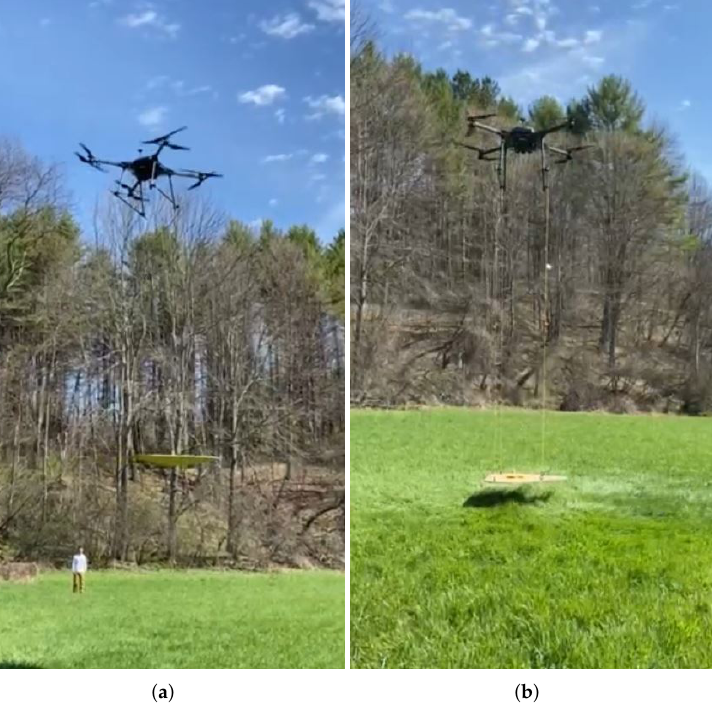
Figure 4. Mock platform maneuverability testing. ( a ) Large standoff. ( b ) Minimal